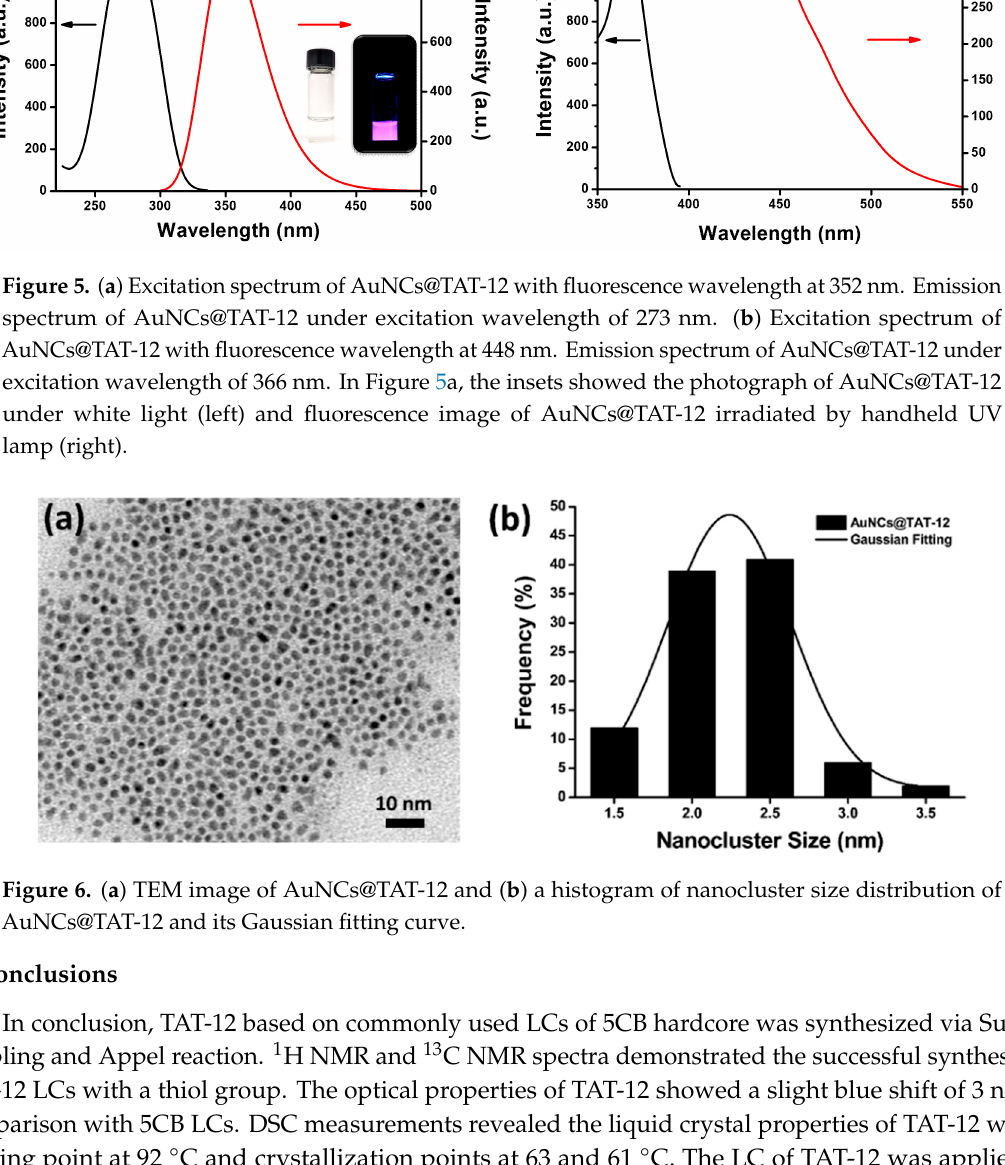
Figure S1: 1 H NMR (upper) and 13 C NMR (lower) spectra of TAT-3 in CDCl 3 ; Figure S2: 1 H NMR (upper) and 13 C NMR (lower) spectra of TAT-4 in CDCl 3 ; Figure S3: 1 H NMR (upper) and 13 C NMR (lower) spectra of TAT-12 in CDCl 3 ; Figure S4: The DSC plots of